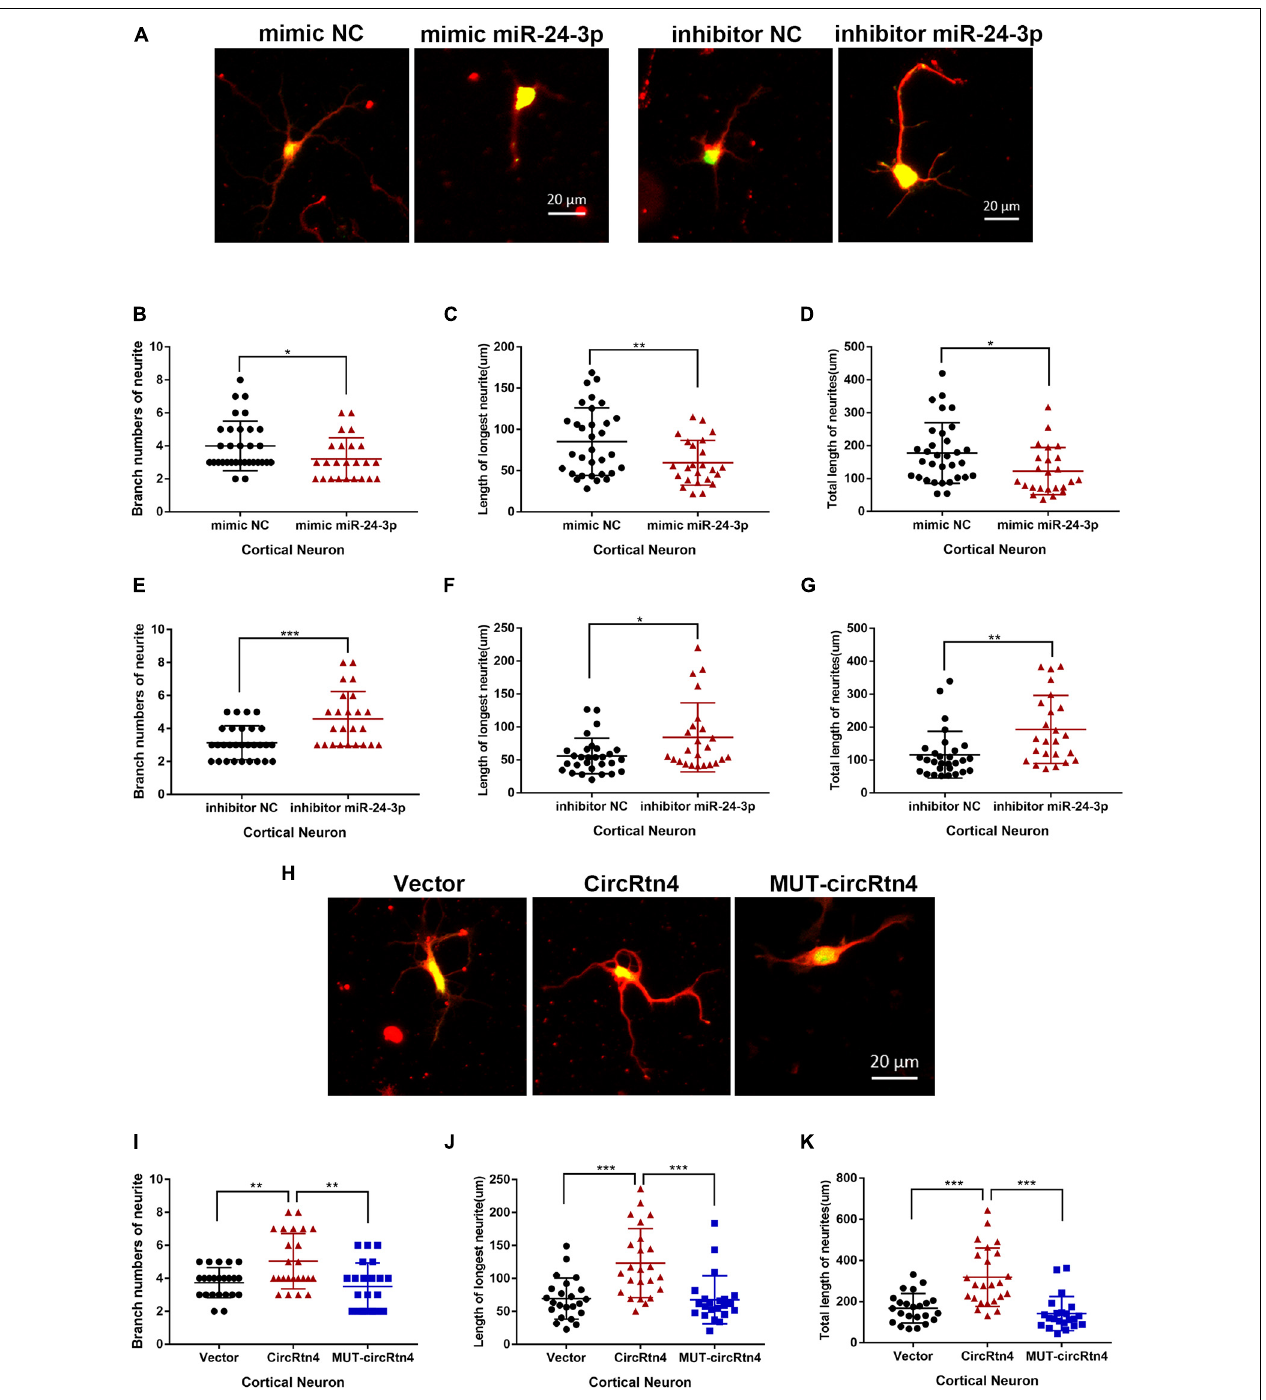
FIGURE 6 | CircRtn4 promotes neurite growth via miR-24-3p. (A) After transfected with miR-24-3p inhibitor or miR-24-3p mimic, primary cortical neurons were fixed and immunostained with anti- β -tubulin III antibody and captured by a Zeiss LSM 710 confocal microscope with a 20 × objective (Red, β -tubulin III; Green, GFP). Primary cortical neurons were cotransfected with 100 nM miR-24-3p mimic (B–D) or inhibitor (E–G) and PEGFP vector (250 ng/ml). The branch numbers of neurite, the length of longest neurite and total length of neurites were quantified by Image-Pro Plus software. The results were shown as the mean ± SD (* p < 0.05, ** p < 0.01, and *** p < 0.001). (H) After transfected with circRtn4 or MUT-circRtn4 vector, primary cortical neurons were fixed and immunostained with anti- β -tubulin III antibody and captured by a Zeiss LSM 710 confocal microscope with a 20 × objective (Red, β -tubulin III; Green, GFP). (I–K) Primary cortical neurons were transfected with overexpression vector of circRtn4 or MUT-circRtn4 (750 ng/ml). The branch numbers of neurite, the length of longest neurite and total length of neurites were quantified by Image-Pro Plus software. The results were shown as the mean ± SD (* p < 0.05, ** p < 0.01, and *** p < 0.001).